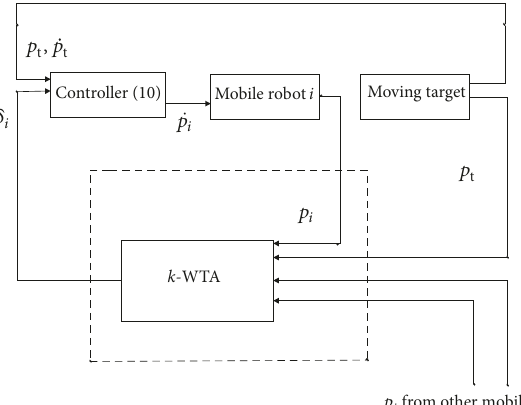
Figure 2: Control block diagram for the 𝑖 th mobile robot in the centralized competitive target tracking control via multiple robots in the situation of all-to-all communications, where subscript 𝑗 ∈ {1,. .. ,𝑖 − 1,𝑖 + 1,.. . ,𝑛}